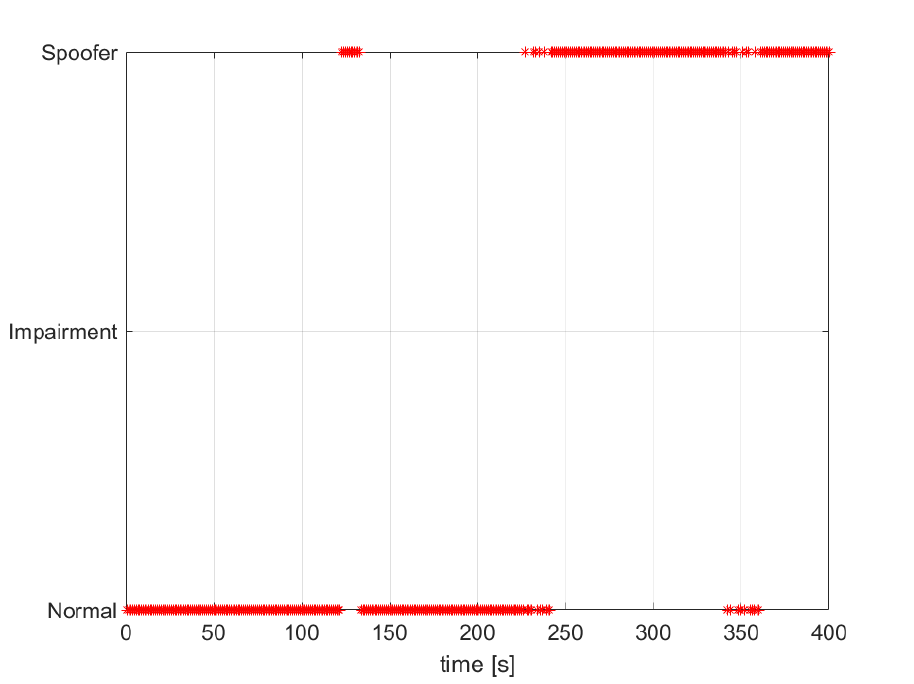
Figure 13. Decision of the spoofing detection algorithm for TEXBAT ds7.